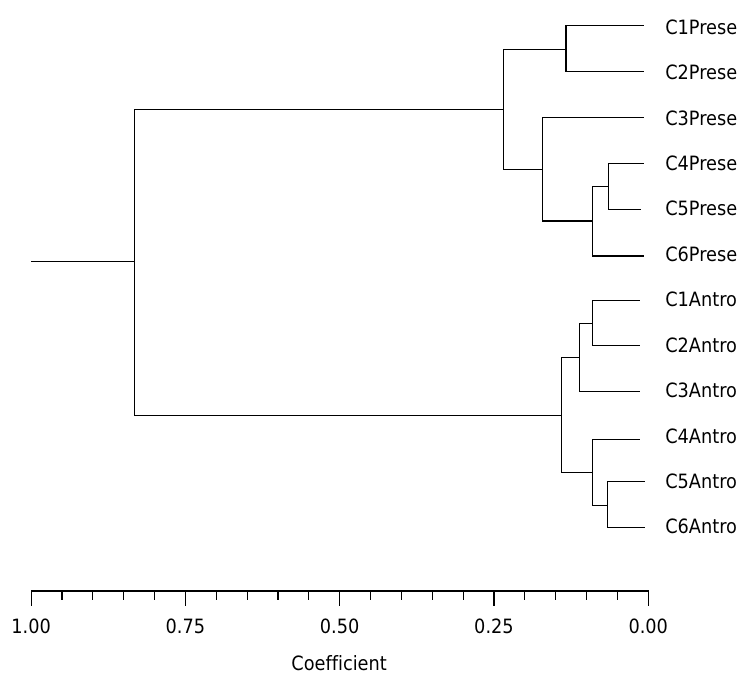
Figure 2. Dendrogram of relation between soil fungi samples from the Preserved (Prese) and Anthropized (Antro) areas of the Parna Catimbau, Caatinga , Pernambuco, Brazil, during the six sample collections (C1, C2, C3, C4, C5, and C6) performed. Bray-Curtis Index; Method of Weighted Pair-Group Method (WPGM). Coperetic analysis: Rf = 0.8. C1: collection 1; C2: collection 2; C3: collection 3; C4: collection 4; C5: collection 5; C6: collection